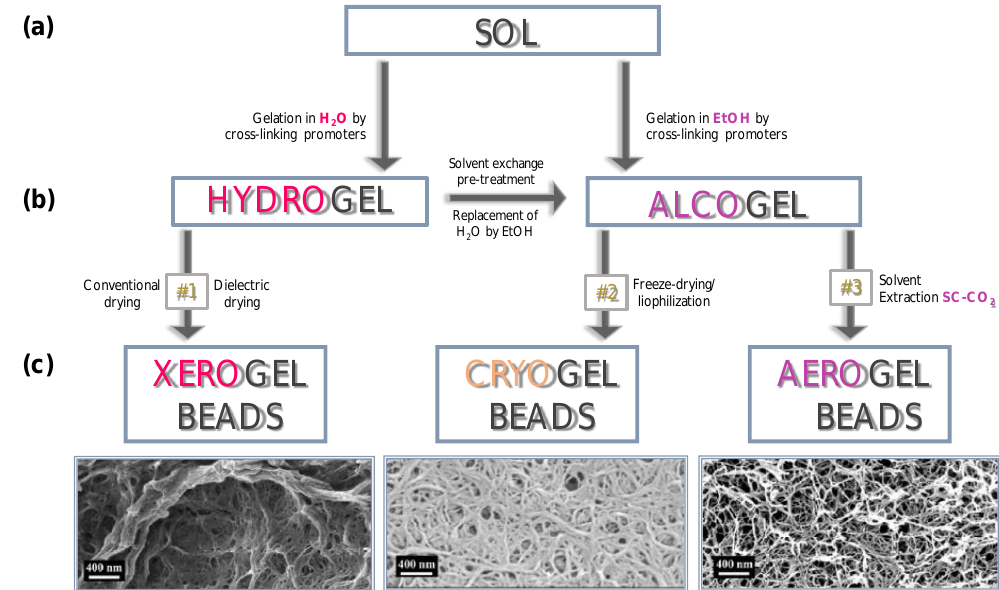
Figure 10. Pathway for the production of xerogels, cryogels and aerogels from polysaccharide based hydrogels via several steps including: ( a ) gelation (SOL → GEL), ( b ) solvent exchange pre-treatment, if required (e.g., the replacement of the water contained in the pores of the hydrogel with a suitable organic solvent), ( c ) drying final step with a specific technology. The images of xerogel, cryogel and aerogel beads were here reprinted (with some modifications) from [176] with permission from Elsevier. Copyright